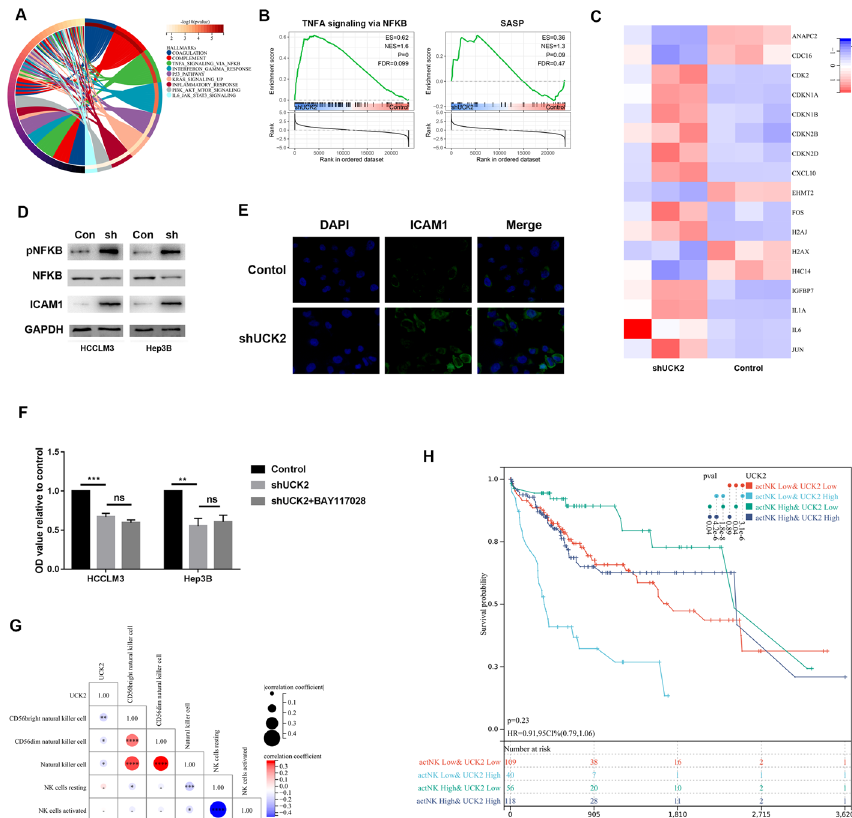
Fig. 6 Targeting UCK2 facilitated NK cell surveillance. A Genes related to innate immune system were enriched in signalling pathway. B GSEA revealed the relationship between signalling pathways and UCK2. C Heatmap showed the expression of genes involved in SASP in the indicated cell lines. D WB examined the protein expression of pNFKB, NFKB and ICAM1 in the indicated cell lines. E IF detected the expression of ICAM1 in the indicated cell lines. F CCK8 assays was used to determine the proliferation of the indicated cell lines; the cells were incubated with NFKB signalling pathway inhibitor BAY11-7082, 7.5 µM. G Correlation between UCK2 and different types of NK cell. H Kaplan–Meier curve suggested the combined effect of UCK2 and activated NK cell on the prognosis of HCC. * p < 0.05; ** p < 0.01; *** p < 0.001; **** p <